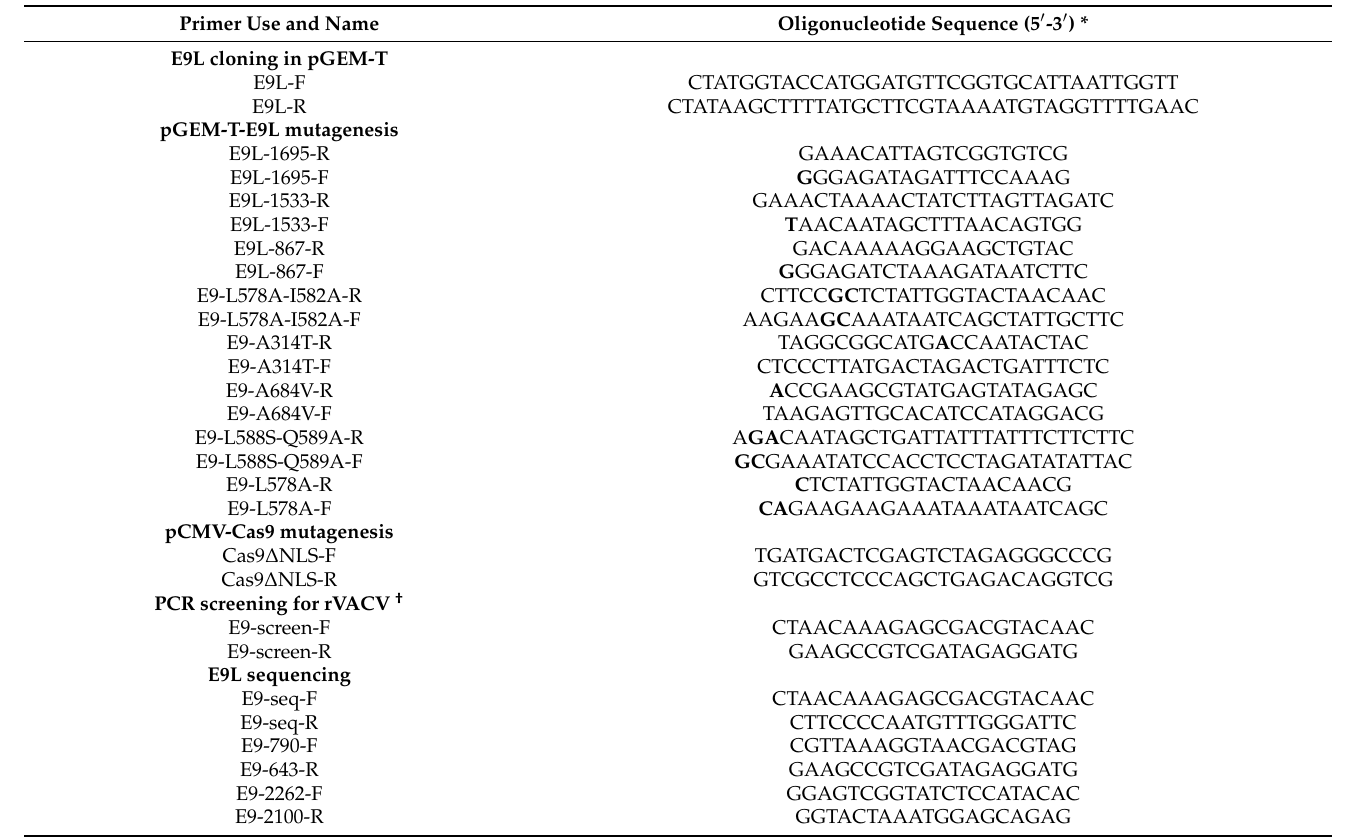
Table 1. Oligonucleotide primers used in this study.